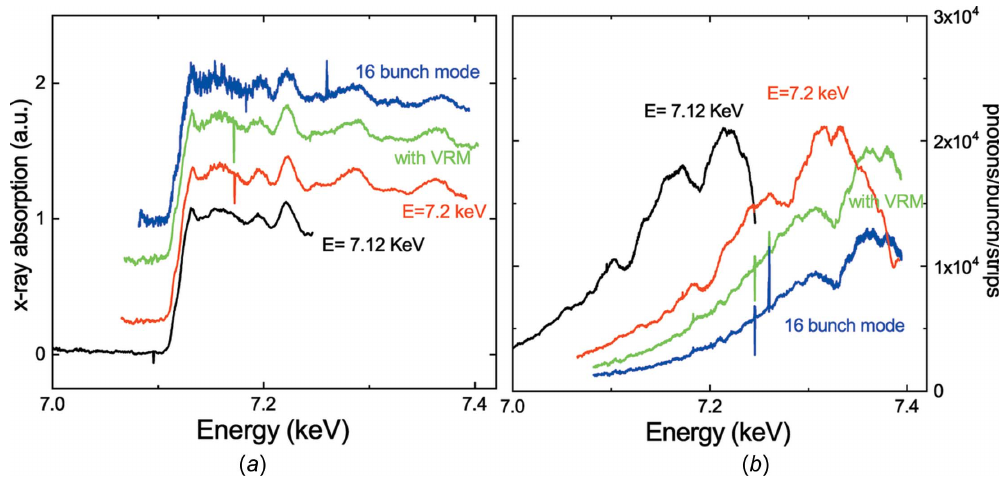
Figure 1 ( a ) Single-pulse XAS measurement of Fe (3.5 m m deposition on a diamond substrate) under ambient conditions in different configurations. Black, red and green lines are spectra acquired during the 4-bunch mode, while the blue spectrum was acquired in the 16-bunch mode. In the black spectrum, the spectrometer is aligned so that the Fe K -edge is in the middle of the energy range; in the red spectrum, the edge is moved towards low energies to increase the energy range; the green spectrum is the same as the red spectrum, but with the beam focused vertically using an additional mirror (VRM); and the blue spectrum is the same as the green spectrum but in the 16-bunch mode. ( b ) The corresponding direct beams (colours